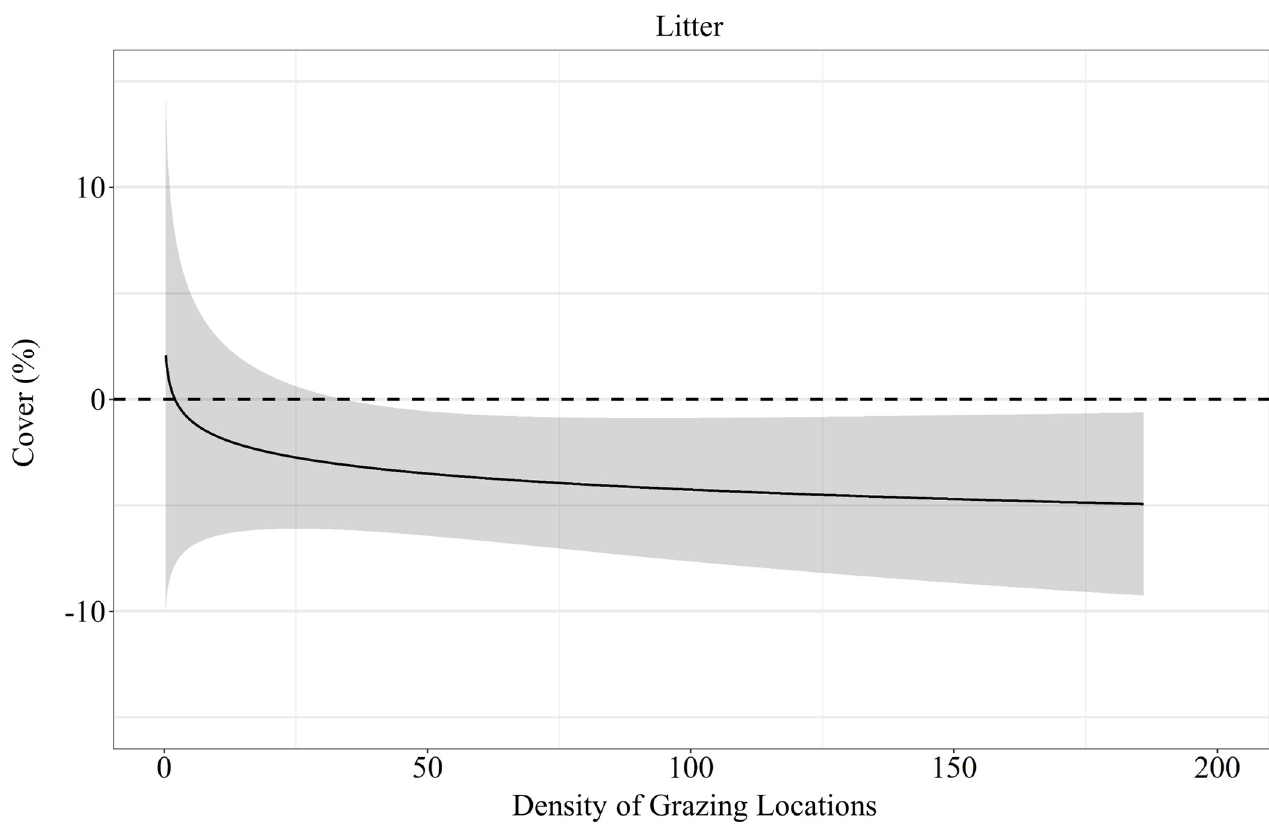
Fig 9. Predicted relationships ( ± 95%CI represented in the shaded area) between pre- post grazing heterogeneity (as indexed by difference of standard deviation among transects) of litter and density of grazing locations within a 50 m radius of transect by cattle grazing dormant northern mixed grass rangeland in 2016 – 2017 & 2017 – 2018 at the Northern Agricultural Research Center Thackeray ranch, Havre, MT.